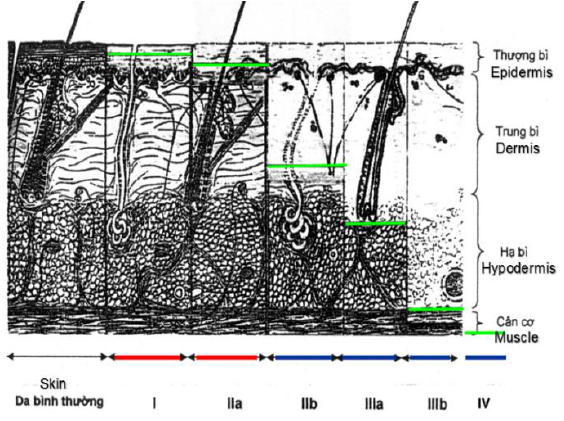
Fig. 4. Different depth levels of burns and scalds [3,15]